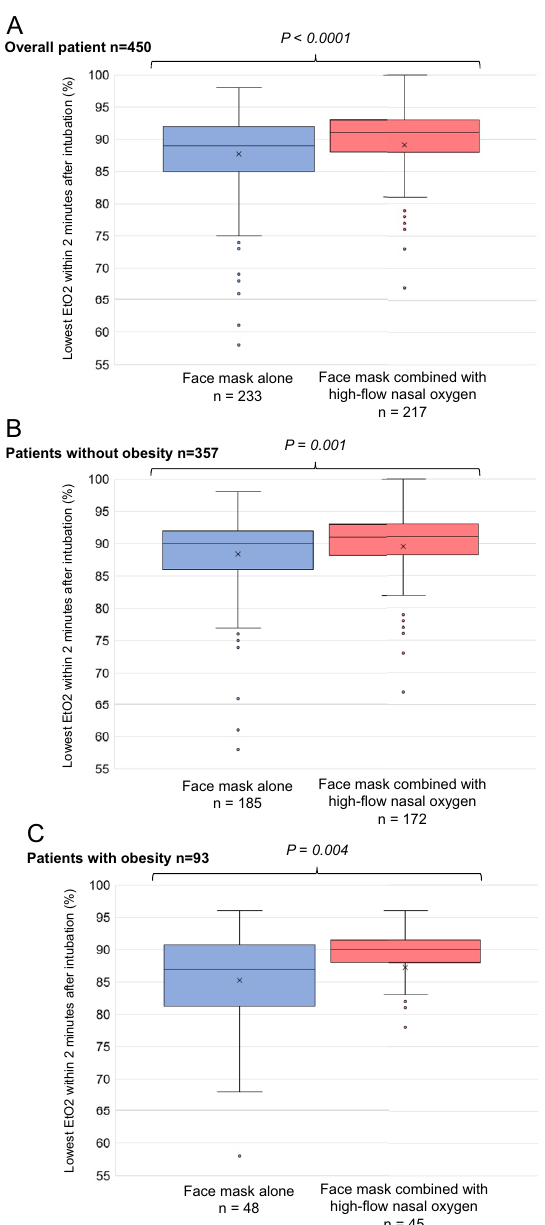
Fig. 2 Primary outcome: end‑tidal oxygen (EtO2) levels within 2 min after intubation in the facemask alone group and the facemask combined with HFNO group, and according to obesity status A . In overall patients B . In patients without obesity C . In patients